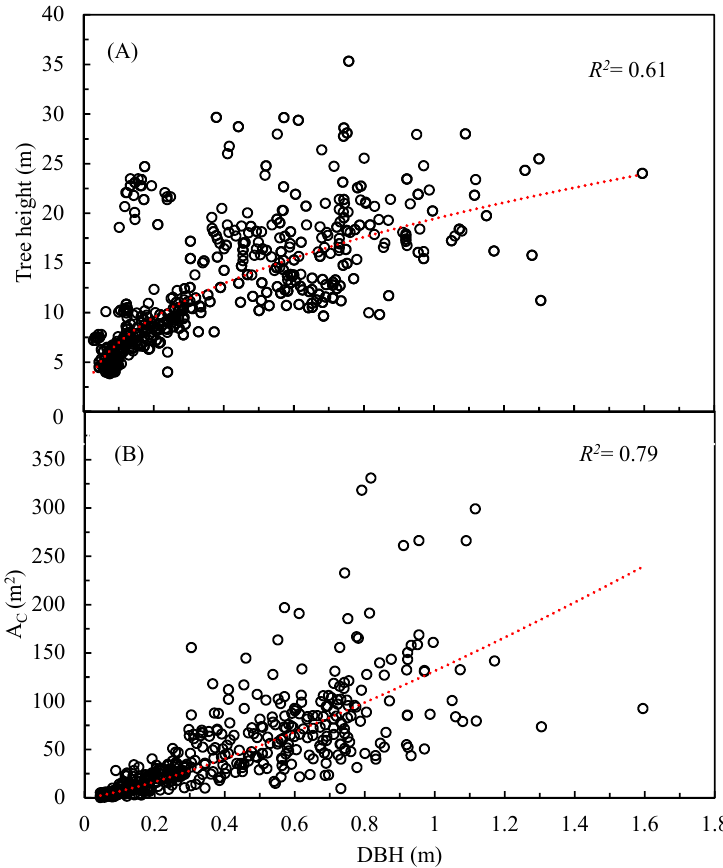
Figure 2. Relationships between stem diameter at breast height (DBH) and total tree height (panel ( A ) and vertically projected crown area (A C ; panel ( B )) of 471 free-standing trees from 13 species growing in urban environments across greater Sydney, Australia. Dotted lines show best-fit functions (A: Tree height = 19.38 × DBH 0.46 ; B: A C = 136.23 × DBH 1.29 ). Coefficients of determination are shown.